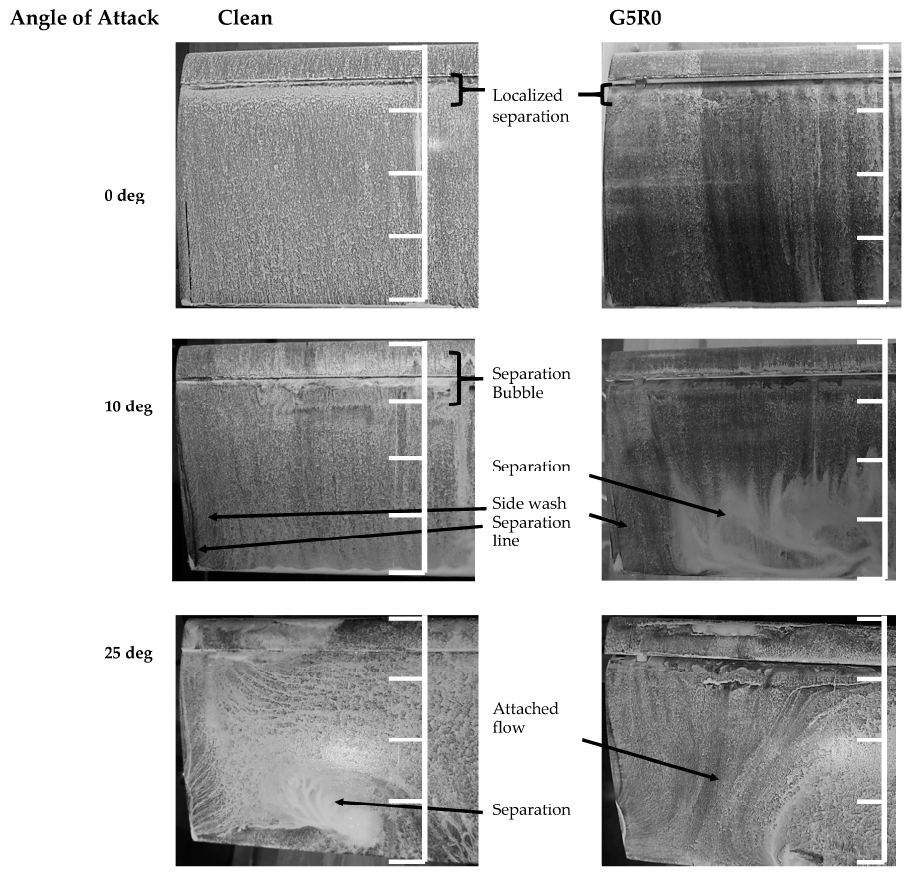
Figure 4. Effect of angle of attack and slat deployment (G5R0 geometry) on surface skin friction patterns. Flow is from top to bottom. Ruler divisions are one-quarter chord.